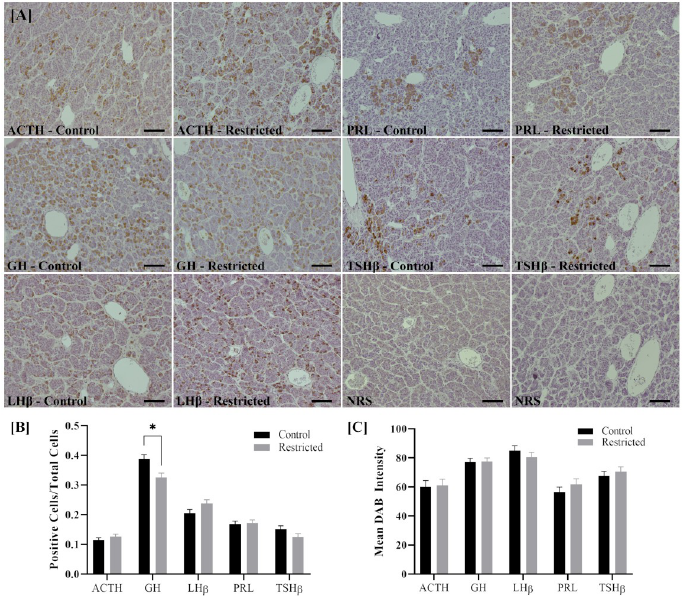
Fig 2. Immunohistological localization [A] of ACTH, GH, LH β , PRL and TSH β in the pituitary of offspring from mothers fed 100% NRC (control; n = 8) or 70% NRC (restricted; n = 8) energy requirements from gestational day 158 to parturition. The percentage of cells immuno-stained for GH in the pituitary was greater ( � P < 0.01) in heifers from control-fed dams as compared to restricted [ B ], with all other hormones showing no difference. There were no differences in staining intensity between control and restricted animals for any of the hormones [ C ]. The NRS panel represents the negative control. Scale bar is 100 μ m. Values are presented as means ± SEM with P < 0.05 considered significant. Legend: ACTH, adrenocorticotropic hormone; GH, growth hormone; LH β , beta unit of luteinizing hormone; PRL, prolactin; TSH β , beta unit of thyroid-stimulating hormone; NRS, normal rabbit serum.